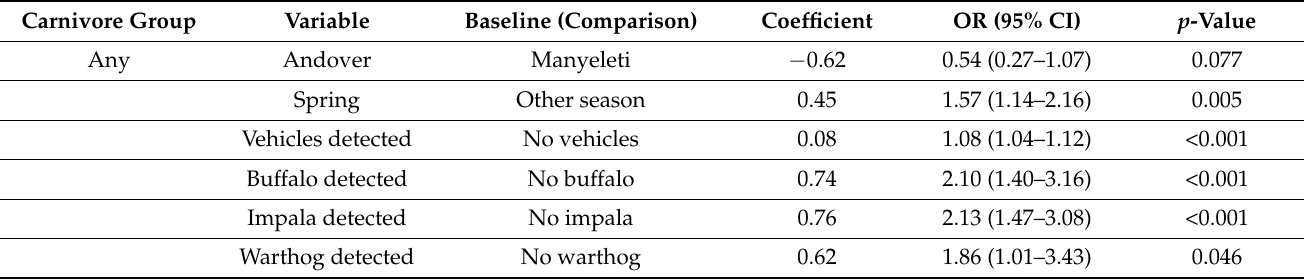
Table 1. Multivariable logistic regression results for the prediction of carnivore species detection within Andover and Manyeleti nature reserves for the years